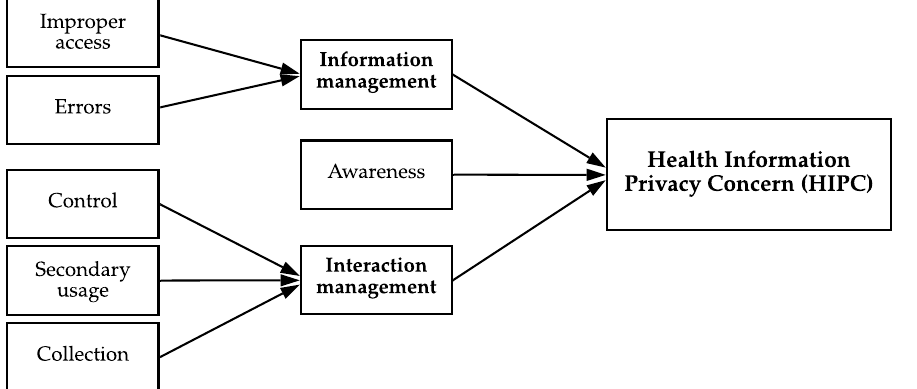
Figure 2. Formative third-order factor to measure the health information privacy concern (adapted from